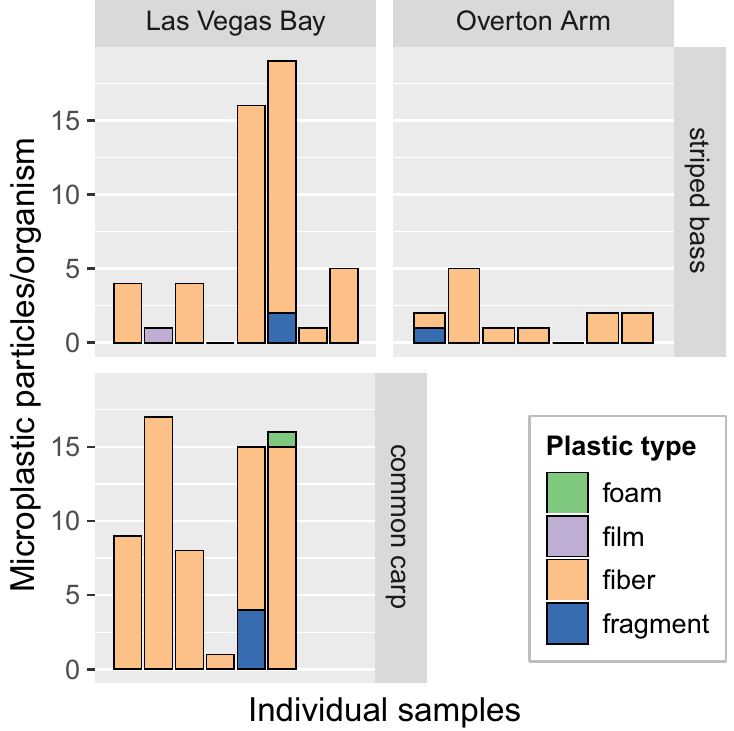
Fig 6. Concentrations of different microplastic types in striped bass and common carp, Lake Mead, 2017. Common carp were not sampled at Overton Arm. LV, Las Vegas.